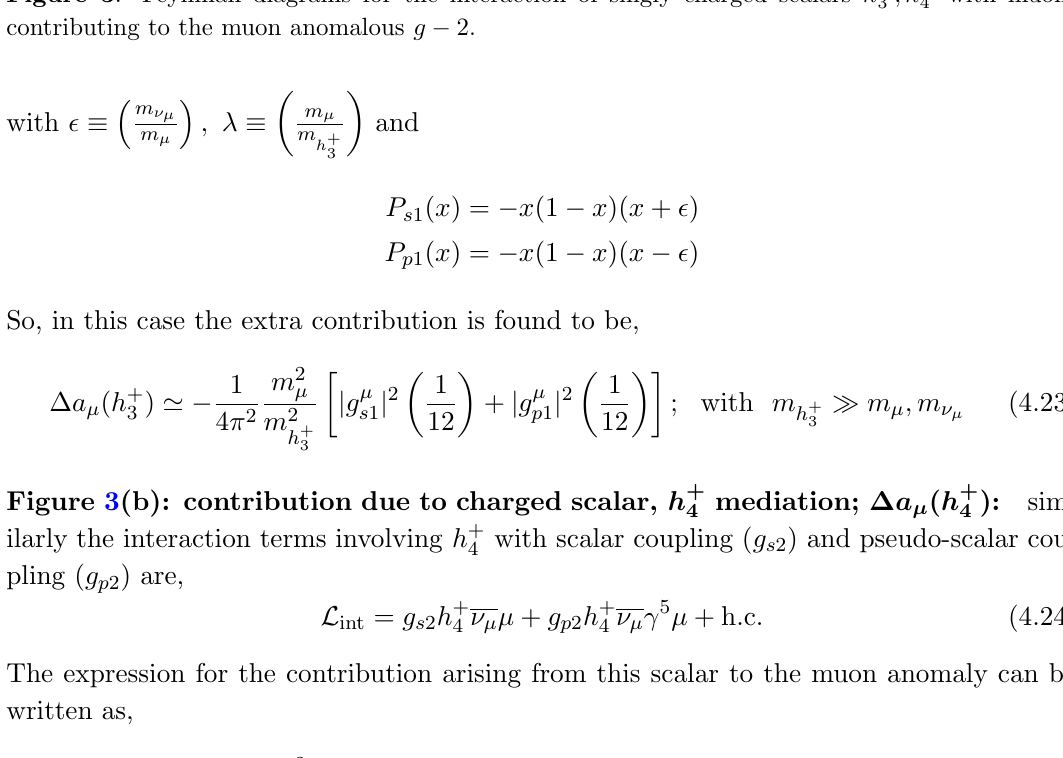
; h (cid:0) with muons 3 4